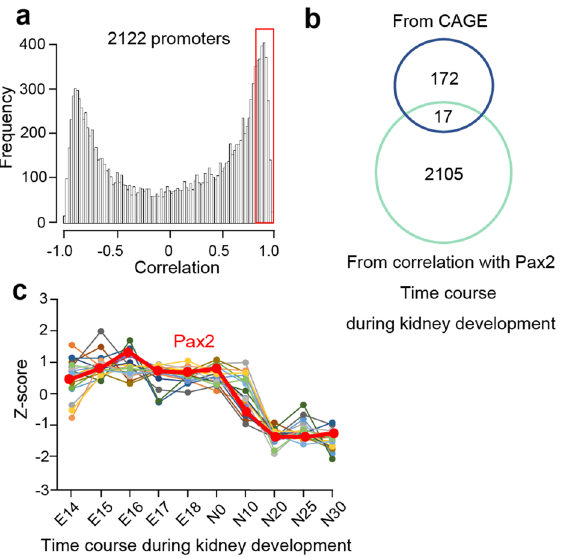
Figure 4. Identification of candidate PAX2 -regulated kidney development genes by merging the gene list from CAGE and FANTOM database. ( a ) Histogram of correlation with Pax2 . The histogram indicates the number of promoters based on correlation with Pax2 using global promoter activities during mouse kidney development from the FANTOM5 database. ( b ) Venn diagram shows the method of prioritizing 17 candidate kidney development genes by comparing gene lists identified from human iPSC culture and data mining of PAX2- regulated mouse genes in the FANTOM database. ( c ) Expression of 17 candidate kidney development genes during mouse embryonic kidney development in the FANTOM database. The bold red line represents Pax2. The vertical axis represents the Z-score representing the expression level for each